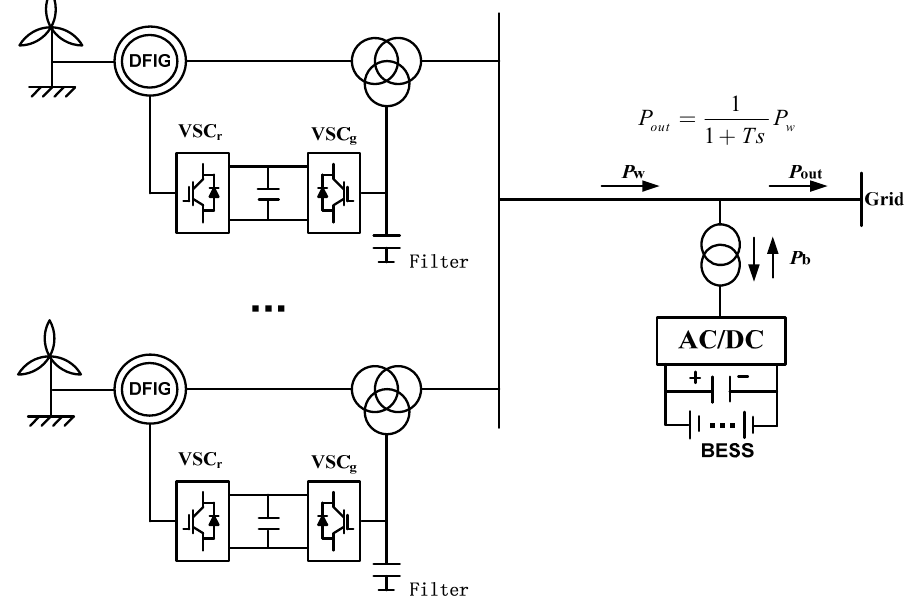
Figure 1. The generation system structure of wind power combined with energy storage